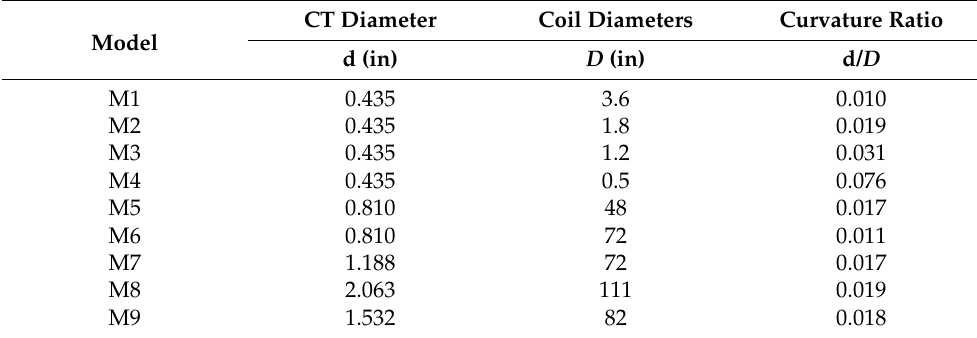
Table 1. Geometric dimensions of coils and tubing.